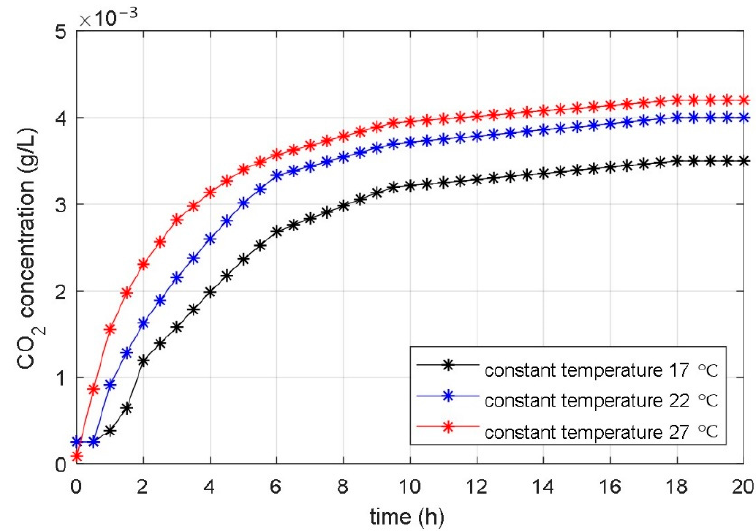
Figure 2. Measured time courses of the CO 2 concentration during the fermentation processes with different bioreactor temperatures.